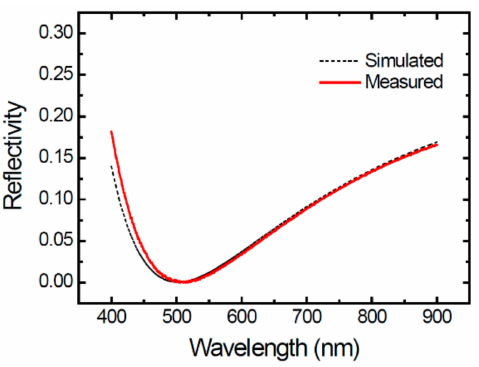
Figure 5. Simulated and measured normal-incidence reflectivity as a function of